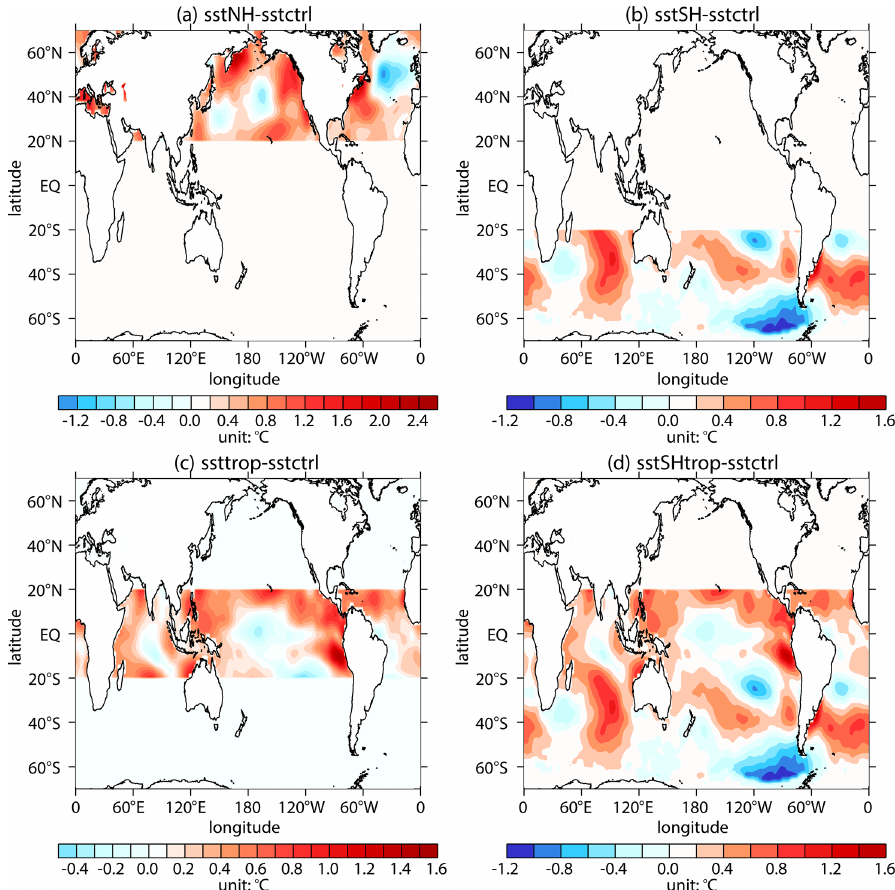
Figure 11. Differences in the SST forcing field between sensitivity experiments ( a sstNH; b sstSH; c ssttrop; d sstSHtrop) and the control experiment